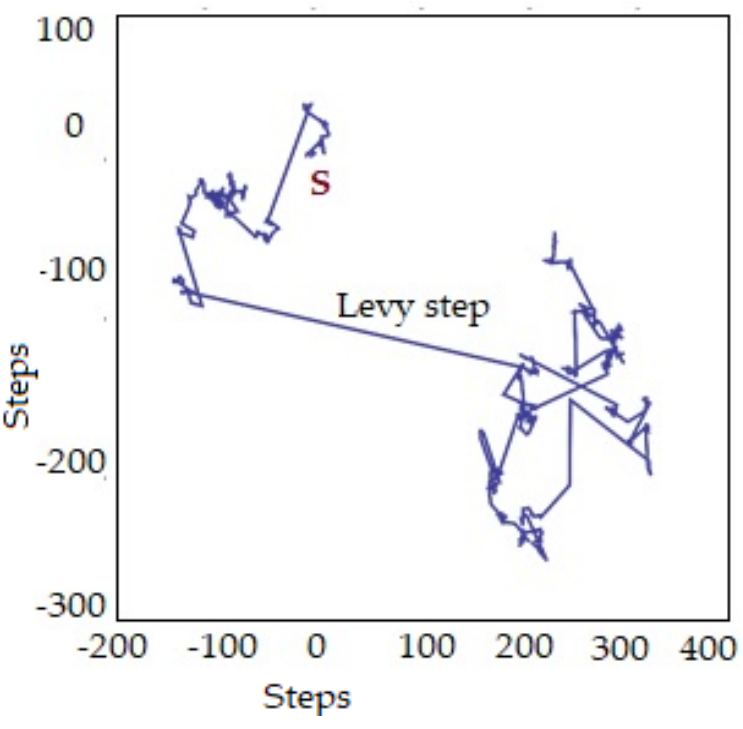
Figure 6. Levy flight example with 1000 steps.